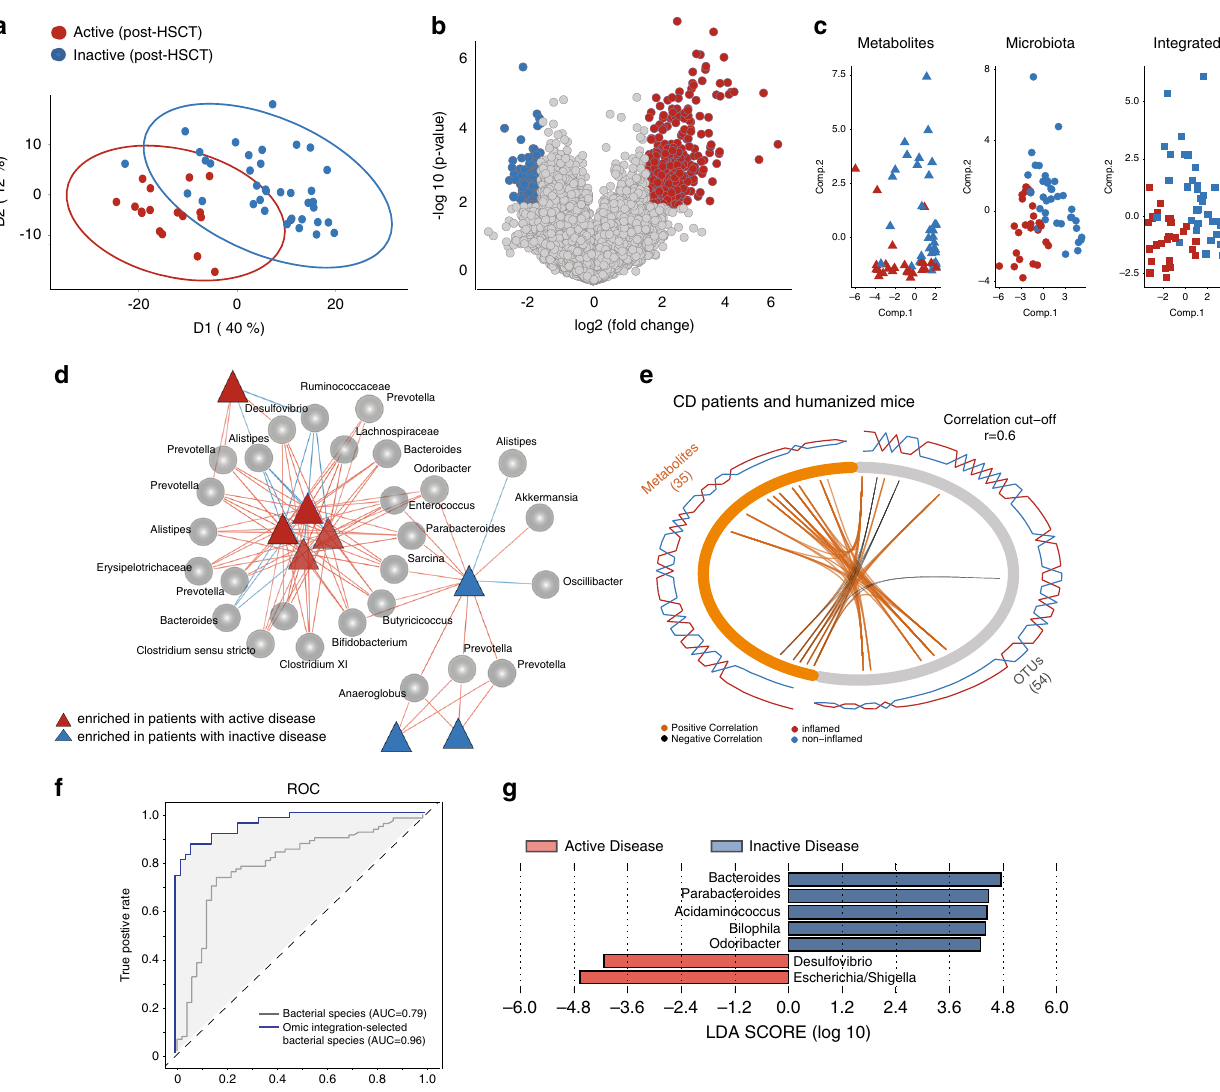
Fig. 3 Multi-omics integration selects predictive targets of in fl ammation. a PLS-DA plot showing separation of metabolite pro fi les between CD patients with active (Red, n = 18) or inactive (Blue, n = 36) disease post-HSCT. b Volcano plot of differentially abundant metabolites selected based on fold change (log 2 ≥ 3) and signi fi cance ( p < 0.01). c Separation of CD patients according to disease activity post-HSCT based on metabolite features, microbiota, and on the integrated microbiome-metabolome dataset . d Relevance network constructed from the similarity matrix to identify the association between OTUs (circles) and metabolite features (triangles), and their link to in fl ammation. Based on the inferred correlation matrix, variables exceeding a correlation coef fi cient threshold of ( r = 0.7) are considered associated. Two clusters were identi fi ed based on the metabolites link to in fl ammation (red = enriched in CD patients with active disease, blue = enriched in CD patients with inactive disease). e Circos plot on the merged CD patients and humanized mice datasets showing the positive and negative correlation ( r ≥ 0.6) between variables of different omics-data (OTUs and metabolites) and is built based on a similarity matrix. Individual tiles on the ring represent individual features, while the connecting lines (orange or black) in the center show positive or negative correlations within and across metabolomics platform above a correlation cut-off coef fi cient of 0.6. The additional line plots on the outer ring visualize the relative abundance of each feature per experimental group. f Receiver operating characteristic (ROC) curves of OTUs interacting with metabolites in the integrated analysis. g Linear discriminant analysis effect size (LEfSe) indicating differentially enriched bacterial OTUs at the genus level of human and mouse fecal bacterial communities corresponding to active disease (red) and inactive disease Remarkably, functional analysis of the gut microbiome of humanized mice clearly demonstrated that genes responsible for regulating the anabolism or catabolism of sulfur-containing amino acids (cysteine and methionine) signi fi cantly contributed to the separation between mice colonized with microbiota from CD patients with active or inactive disease (Fig. 4f). In mice colonized with microbiota from CD patients with inactive disease, we observed an enrichment of functional modules of glutathione biosynthesis, known to be involved in bio-reductive reactions